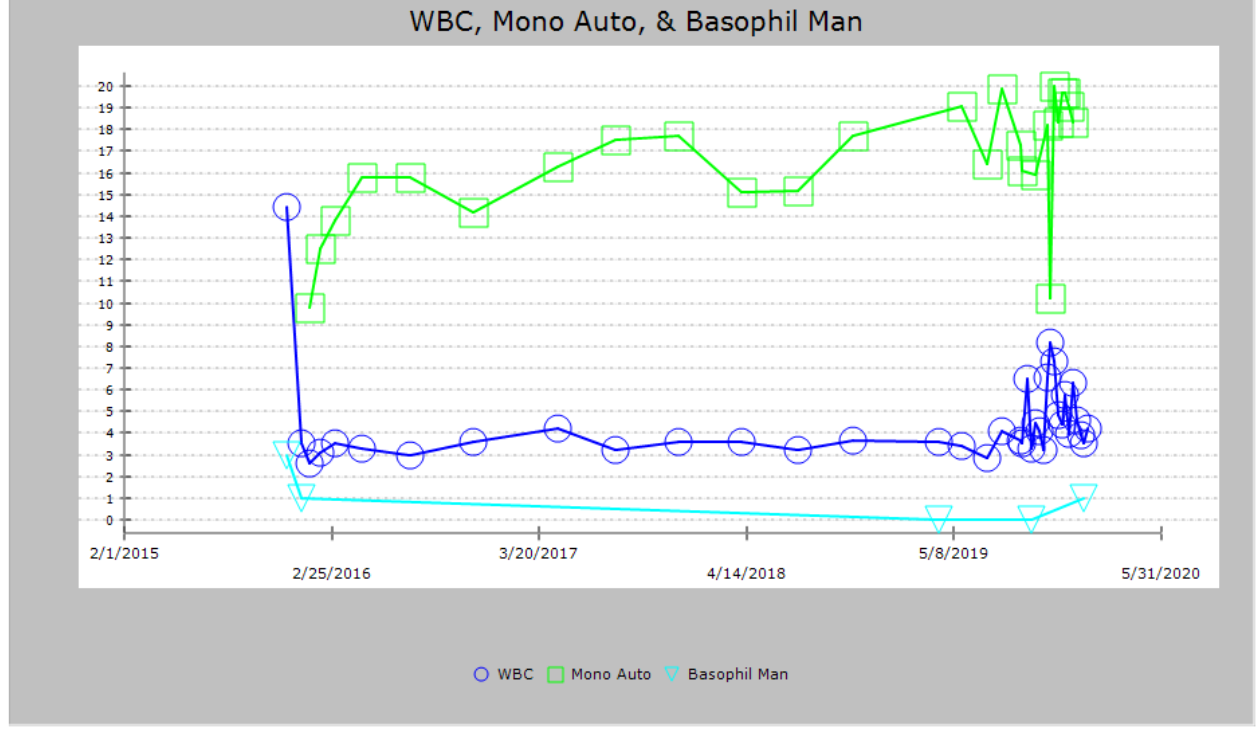
Figure 3. Graphical trend of white blood cell (WBC) count, lymphocytes and basophils.